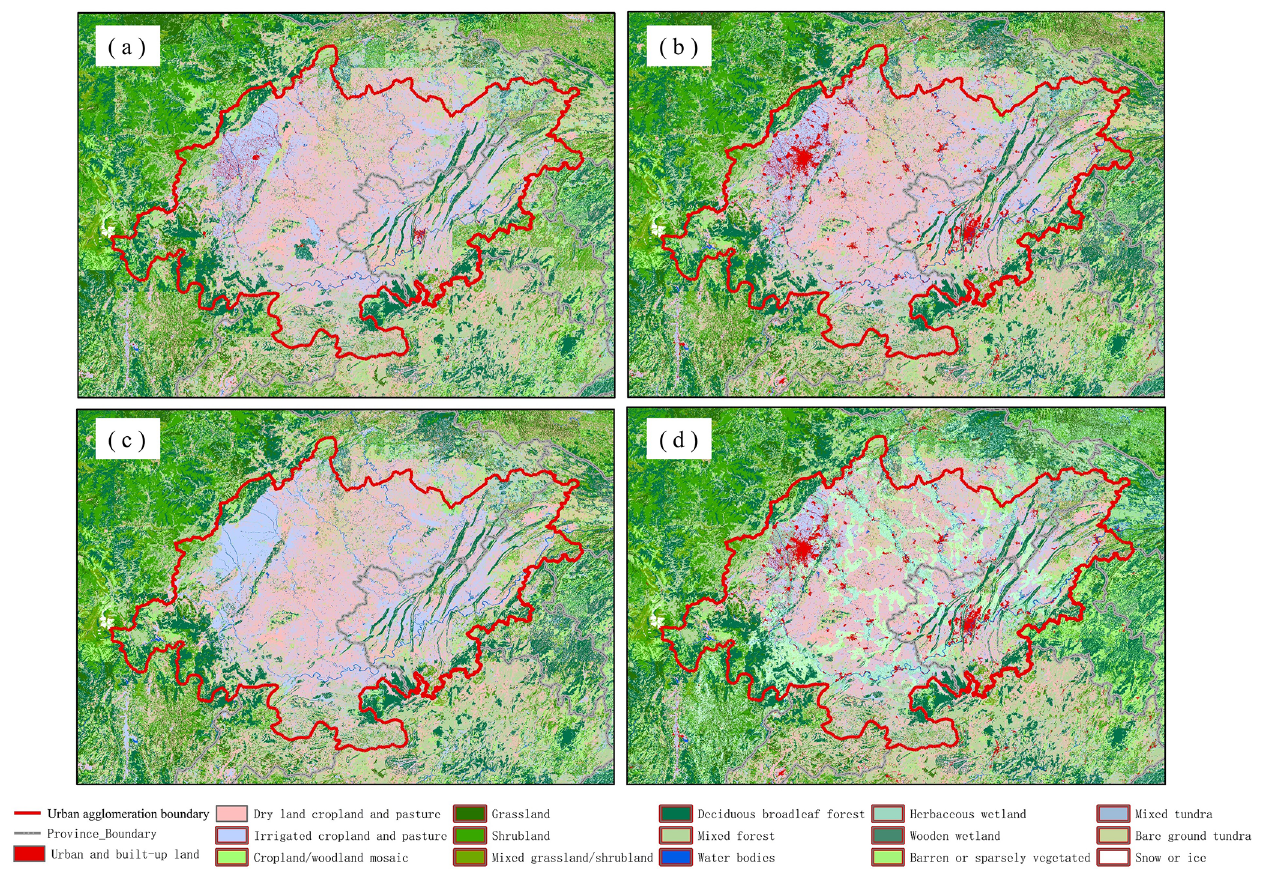
Figure 2. Land use/land cover in CCUA: (a) 1980; (b) 2018; (c) non-urban based on 2018 data; (d) planned future land use based on 2018